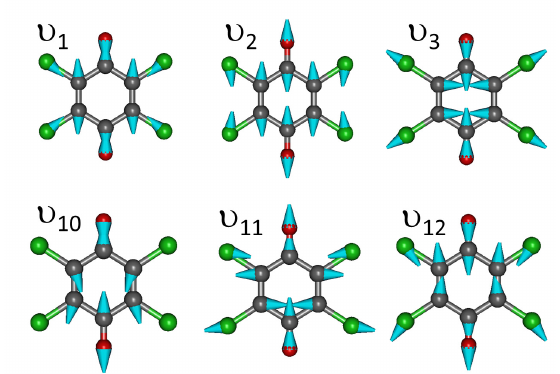
Figure 8. In the upper row, the symmetric a g -modes ν 1 , ν 2 , and ν 3 of CA are visualized. The ungerade b 1 u -modes ν 10 , ν 11 , and ν 12 are listed in the lower row.